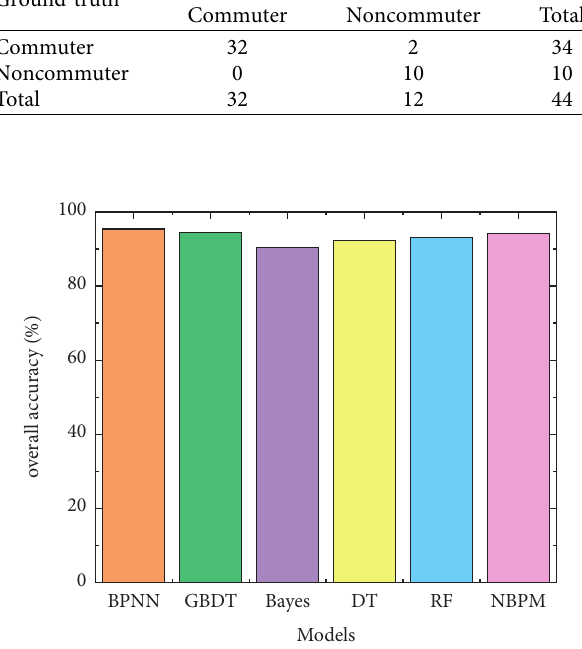
Figure 10: The comparison results of model